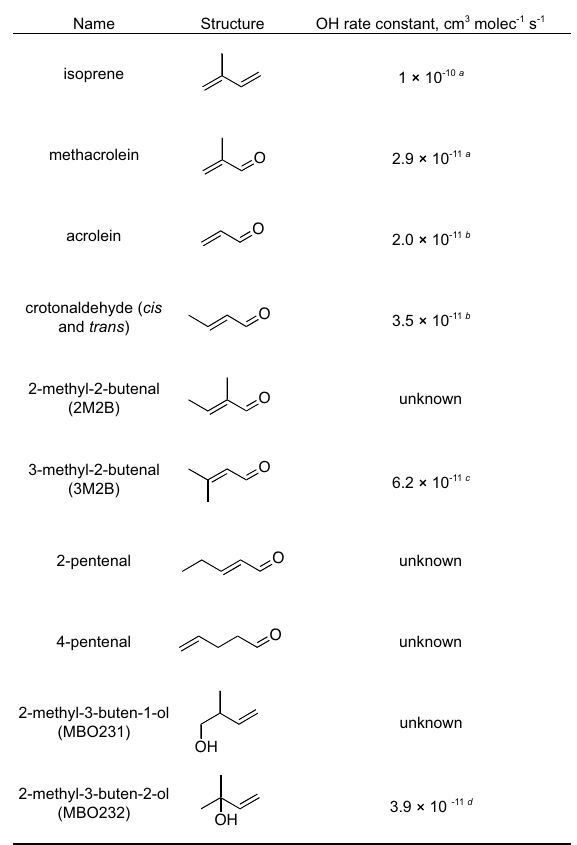
Table 1. Hydrocarbons